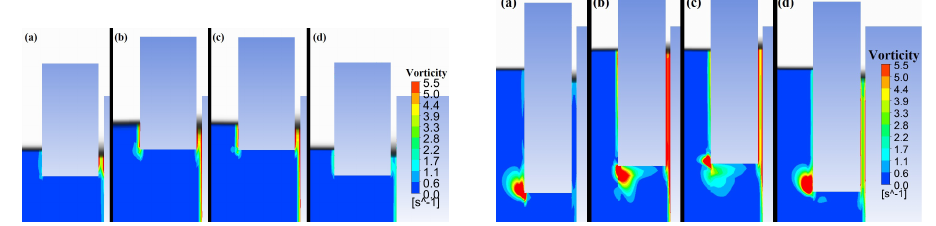
Figure 10. Spanwise vorticity component for h = 0.6 m, A i = 0.05 m and ω = 3.74 rad.s − 1 at time